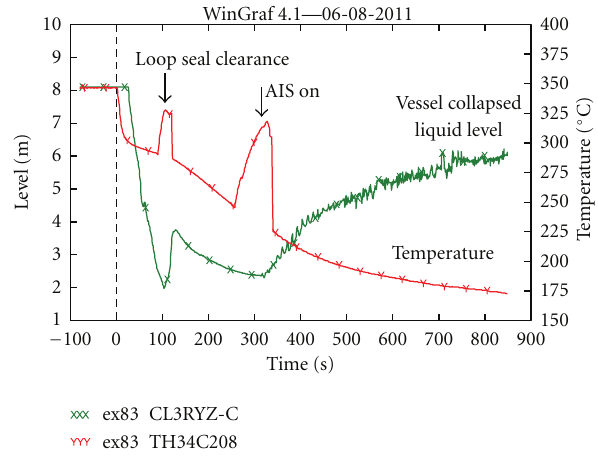
Figure 5: Heater rod temperature and vessel-collapsed liquid level in a small 10% cold leg break